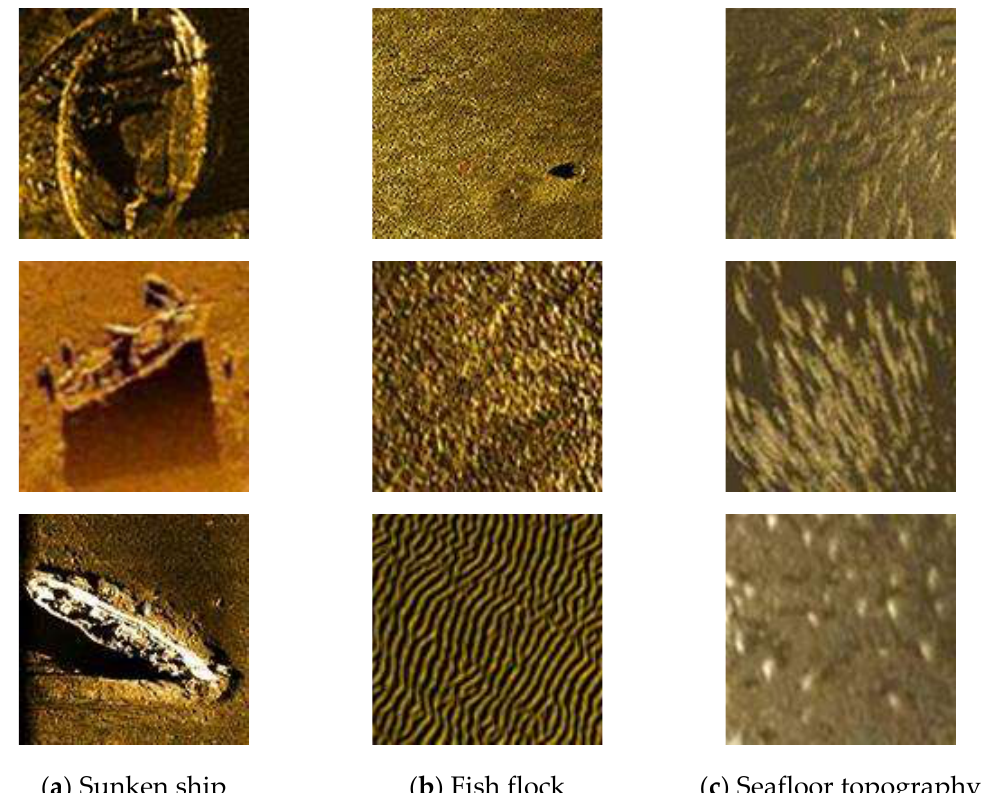
Figure 2. The demonstration of the original side scan sonar images from three kinds of datasets including Sunken Ship, Fish Flock, Seafloor Topography. Table 1. Detailed description of the